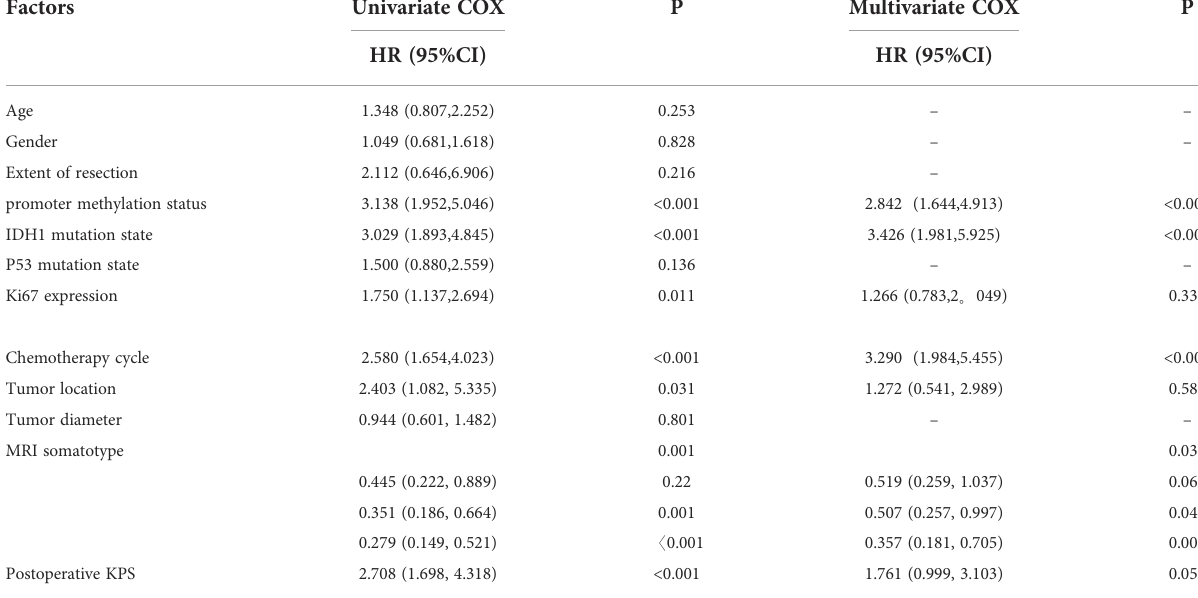
TABLE 5 Univariate and multivariate Cox proportional hazards model results for progression-free survival.